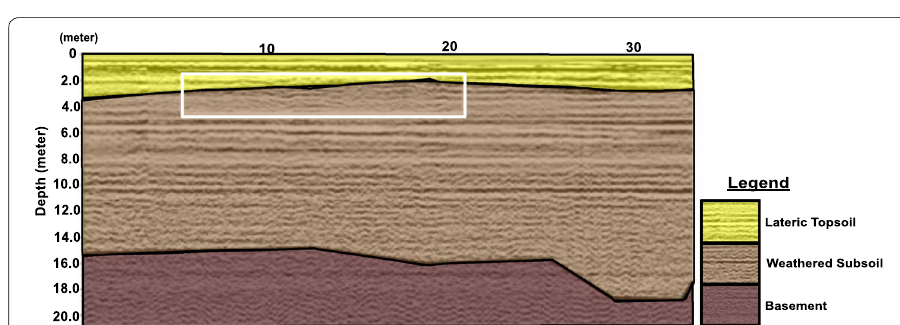
Fig. 27 GPR profile 5 overlaid on Geo-electric section traverse 5